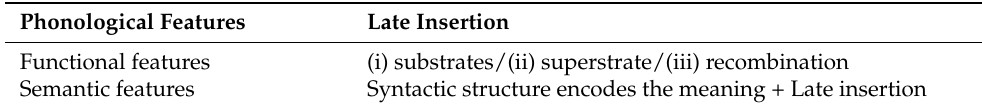
Table 3. The logical possibilities of recombination based on a late-insertion-based exoskeletal model for Creoles.